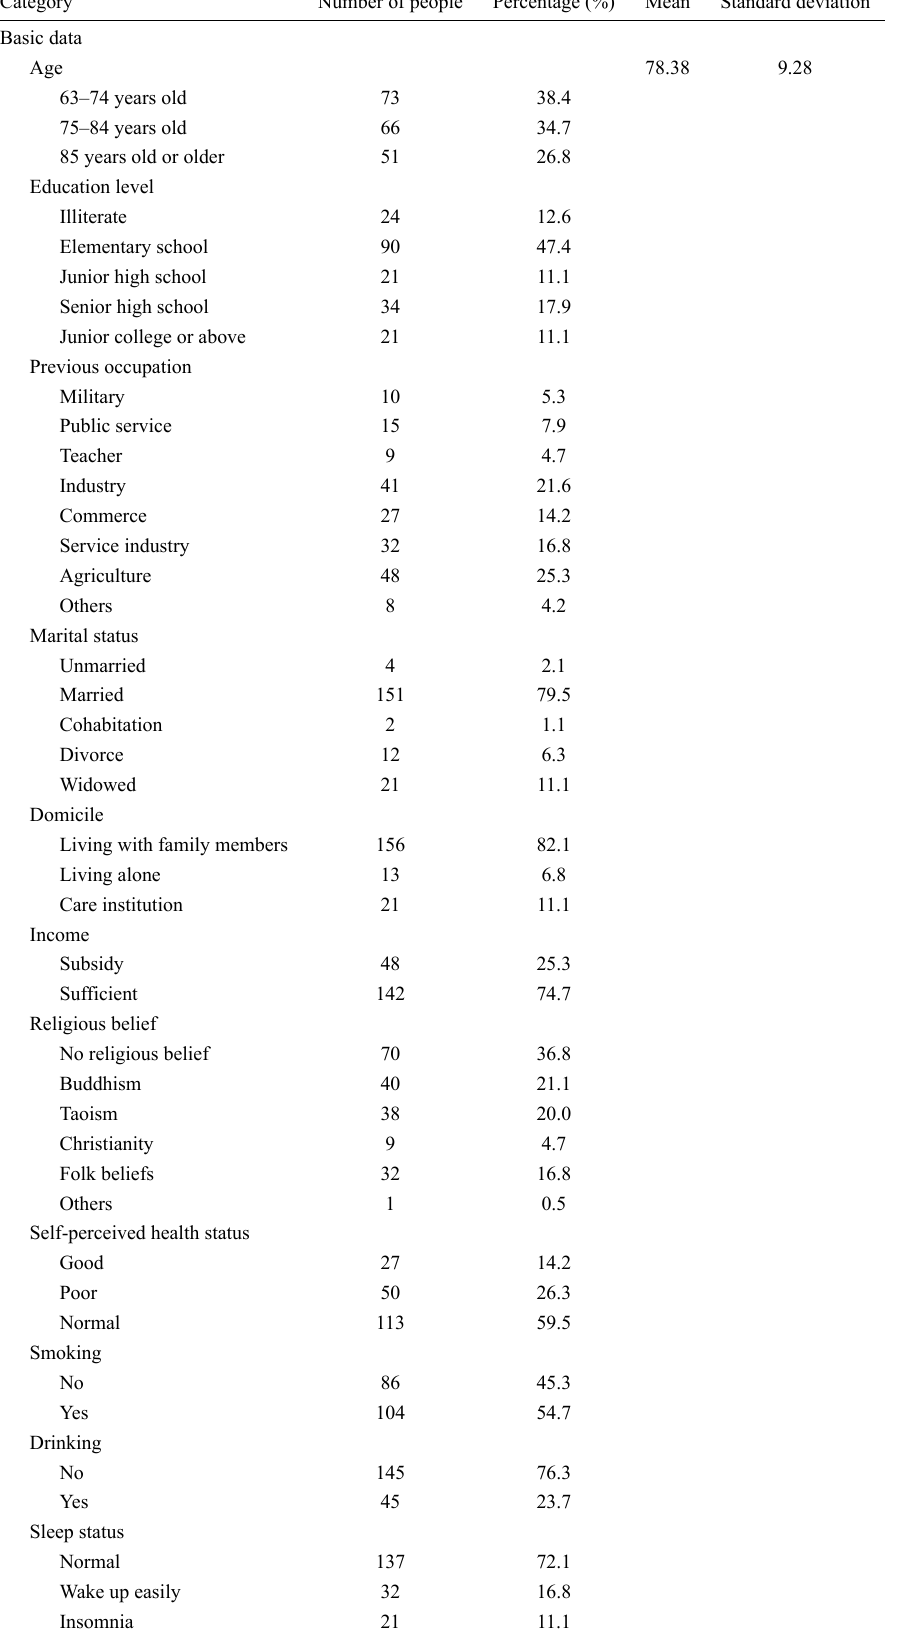
Table 1. Descriptive analysis of basic data, physical characteristics, cognitive function, community participation and mental health state of the elderly men with depression (n =